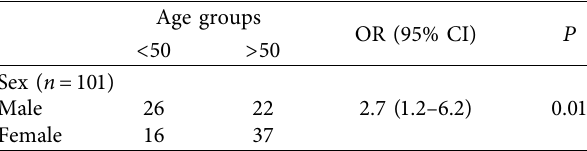
Figure 2: Microphotographs illustrating tumor borders: (a) expansile tumor border and (b) infiltrating tumor border. Table 4: Correlation between sex and age